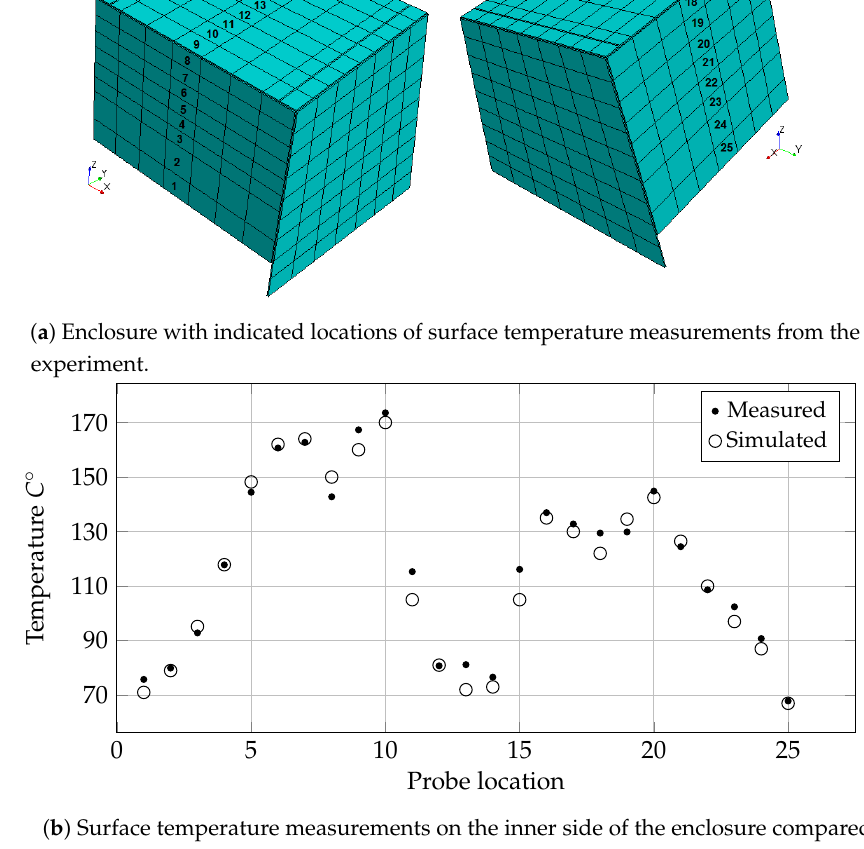
Figure 7. Experimentally and computationally determined temperatures of the